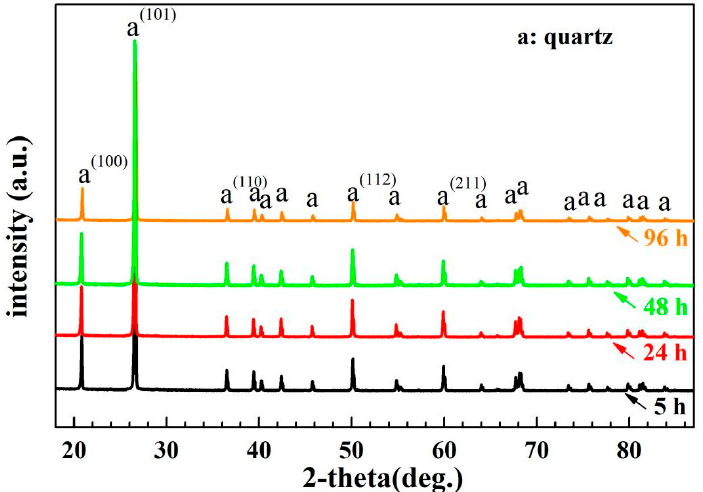
Figure 2. XRD patterns for the quartz powders after holding at 1000 °C for different time.